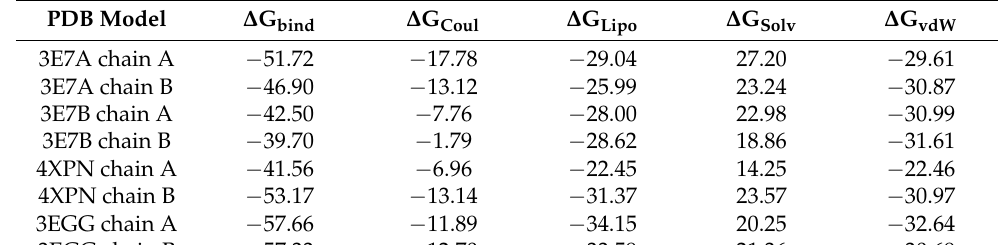
Table 1. ∆ G bind values and their single contributions. ∆ G bind values are expressed as electrostatic ( ∆ G Coul ), lipophilic ( ∆ G Lipo ), solvation ( ∆ G Solv ) and van der Waals ( ∆ G vdW ) components, calculated for all best complexes of SIX2G with the different 3D structures of the protein PP1, obtained by means of docking simulations. All ∆ G values are expressed as kcal/mol.